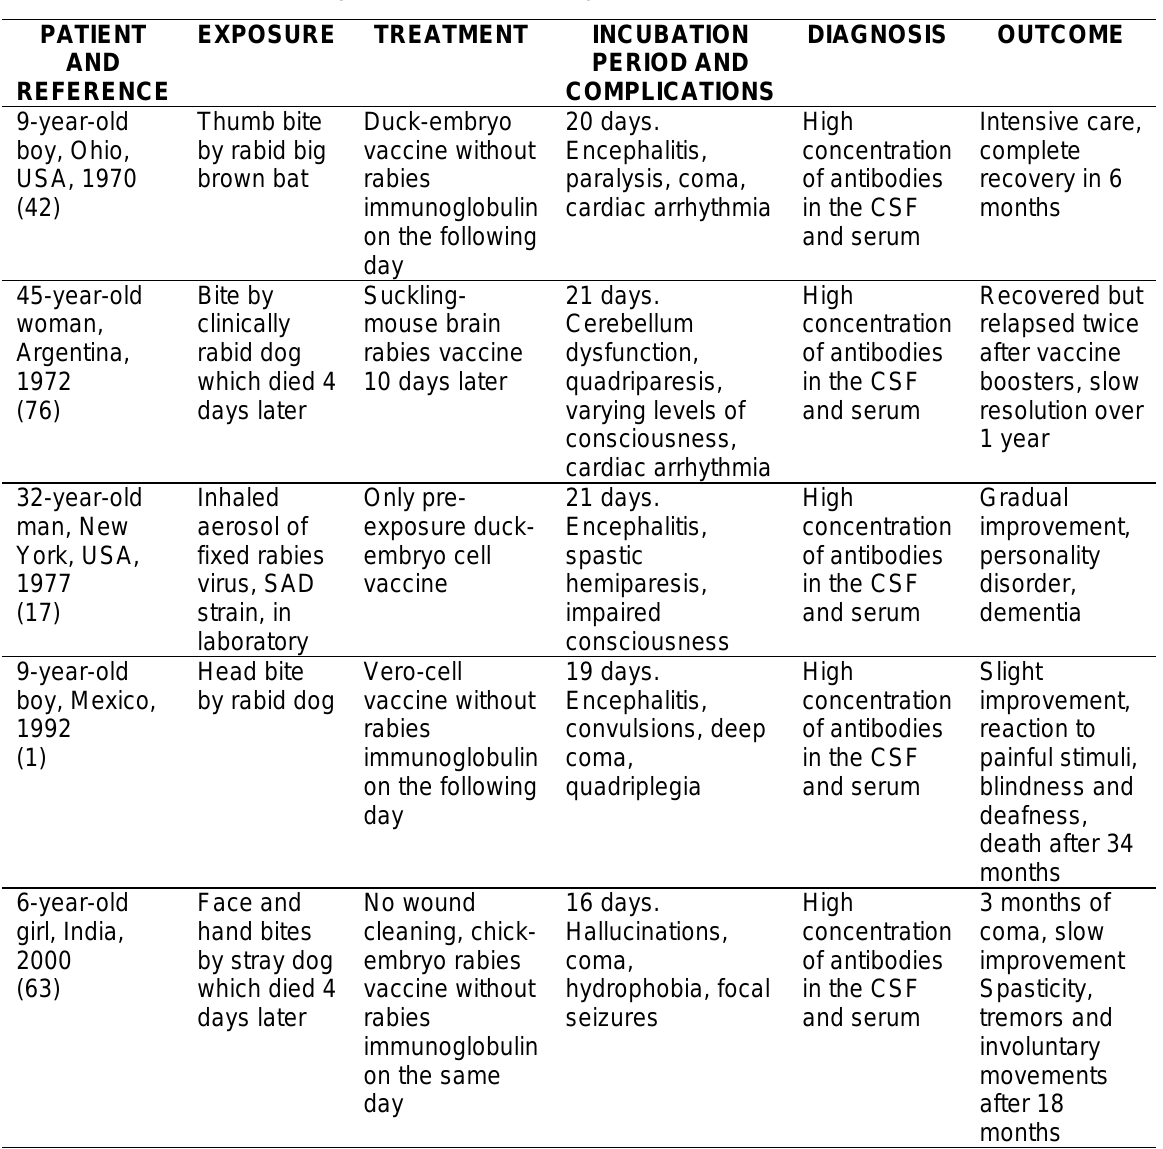
Table 3: Human recovery from rabies encephalitis. PATIENT